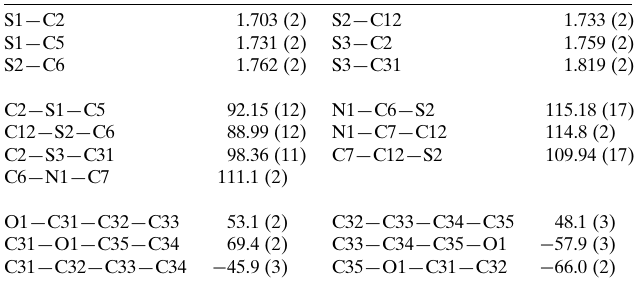
Table 1 Selected geometric parameters (A˚ , (cid:2) ).